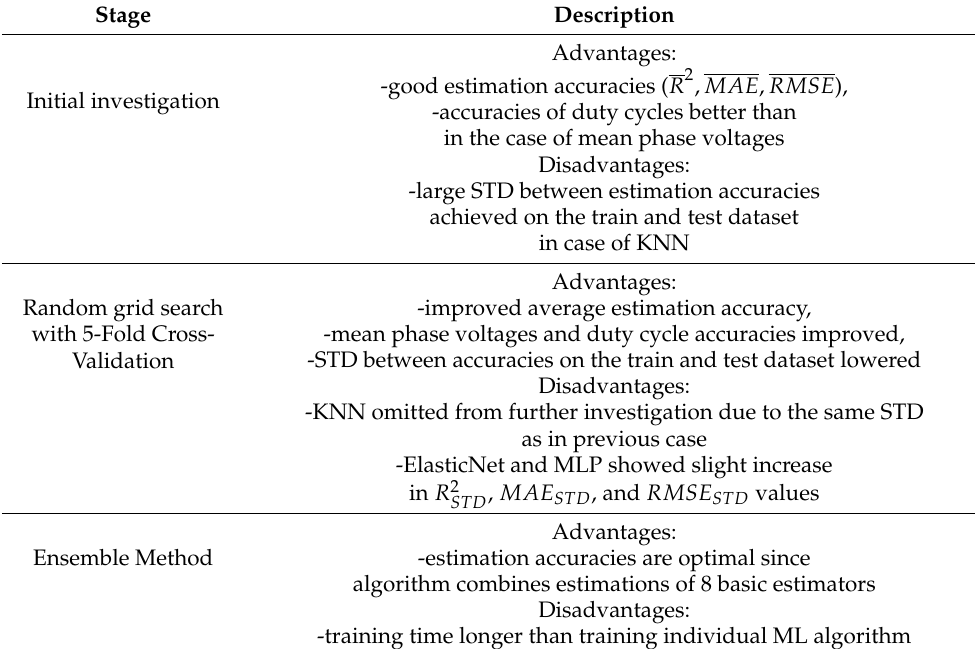
Table 15. Summarized discussion with improvements obtained at each stage of methodology development in the case of the black-box inverter and inverter compensation scheme model. Stage